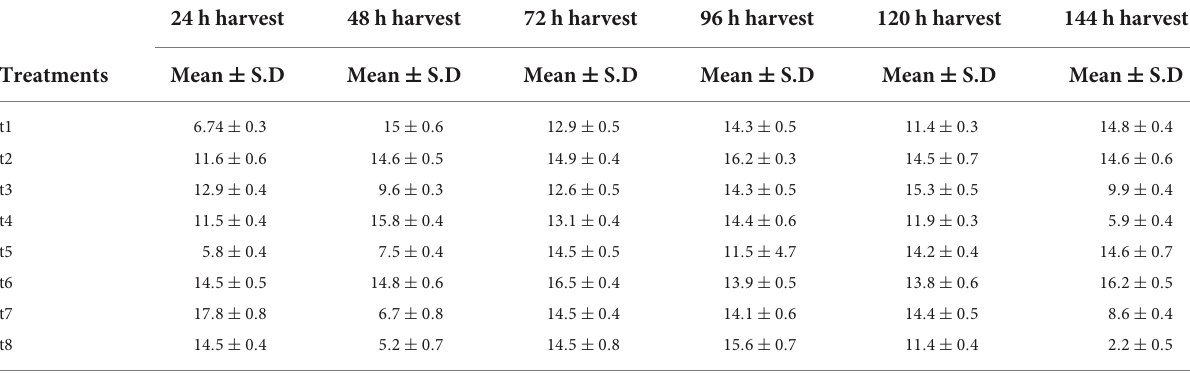
TABLE 11 SOD levels (U g − 1 ) of Silybum marianum exposed to different treatments of elicitors.